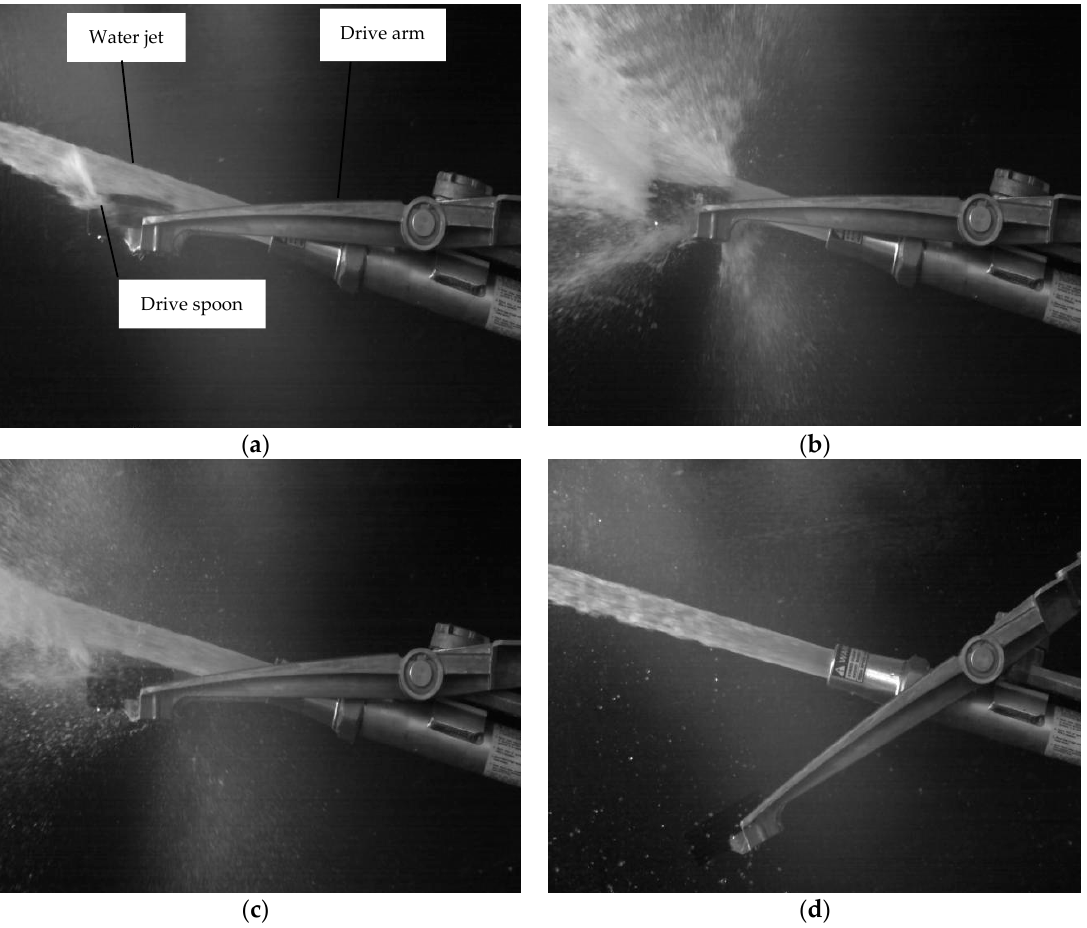
Figure 4. Movement process of the drive arm: ( a ) drive spoon began to cut into water jet; ( b ) drive spoon in water jet; ( c ) drive spoon starting out of water jet, ( d ) drive spoon completely out of water jet.